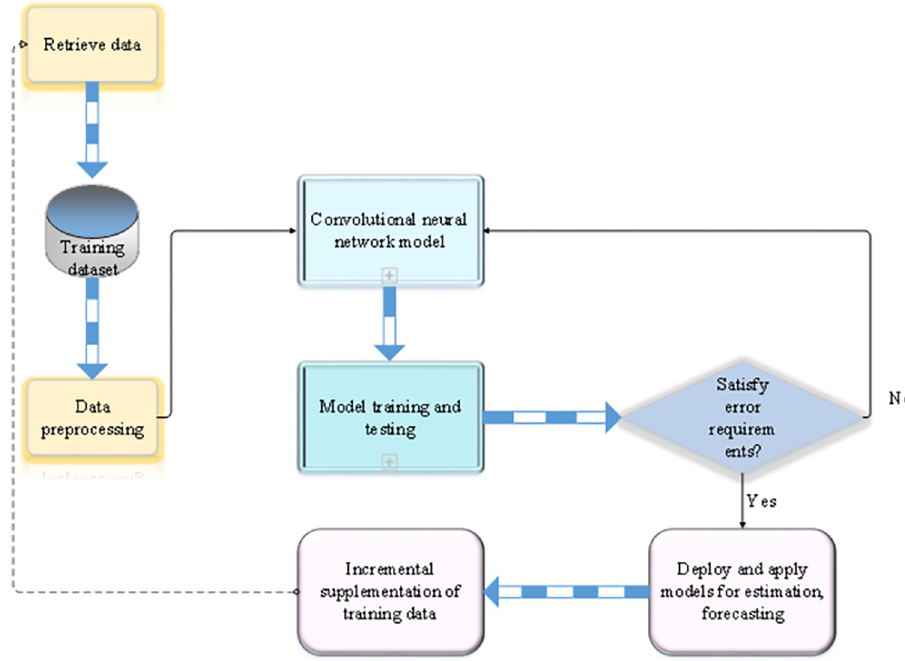
Fig 4. CDC energy-efficient workflow of